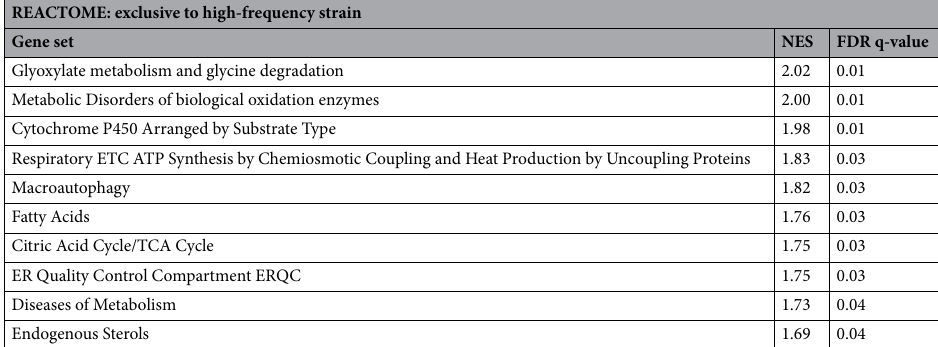
Table 3. Metabolism-related Gene sets from Reactome exclusively enriched following high-frequency tensile strain. FDR, false discovery rate; NES, normalized enrichment score.